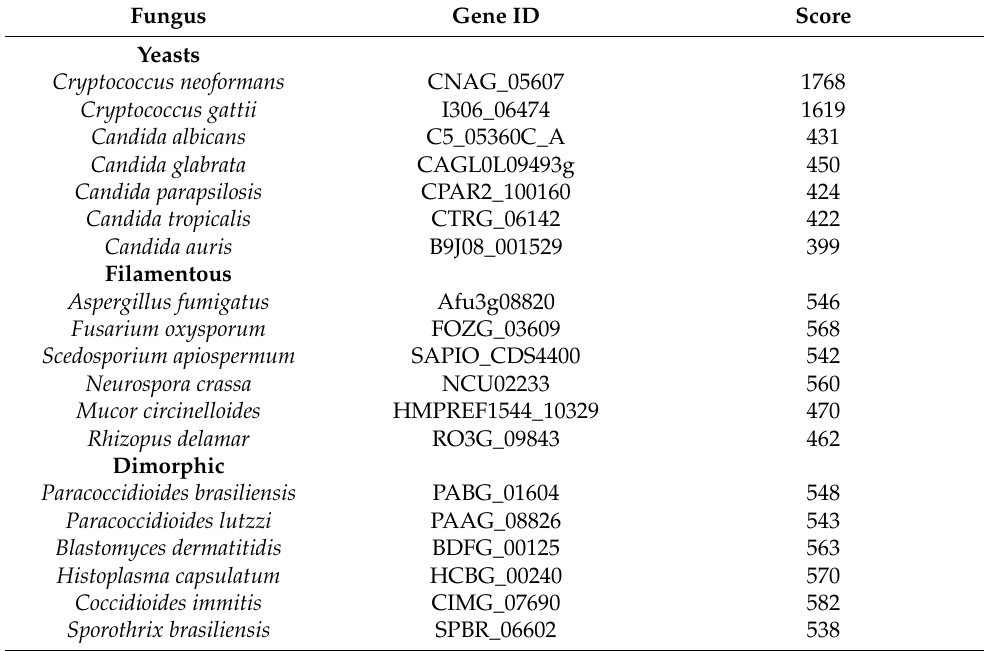
Table 1. Sterylglucosidase 1 (Sgl1) homologs in fungi. Score values obtained by “Blastp” of the Cryptococcus neoformans Sgl1 (CNAG_05607) amino acid sequence into the FungiDB protein